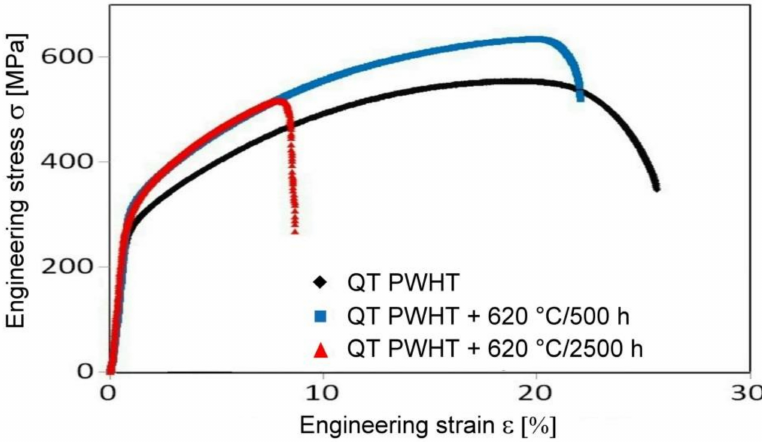
Figure 9. Ageing effects at 620 ◦ C on tensile deformation behavior of T92/TP316H dissimilar weldments with Ni-based weld metal.